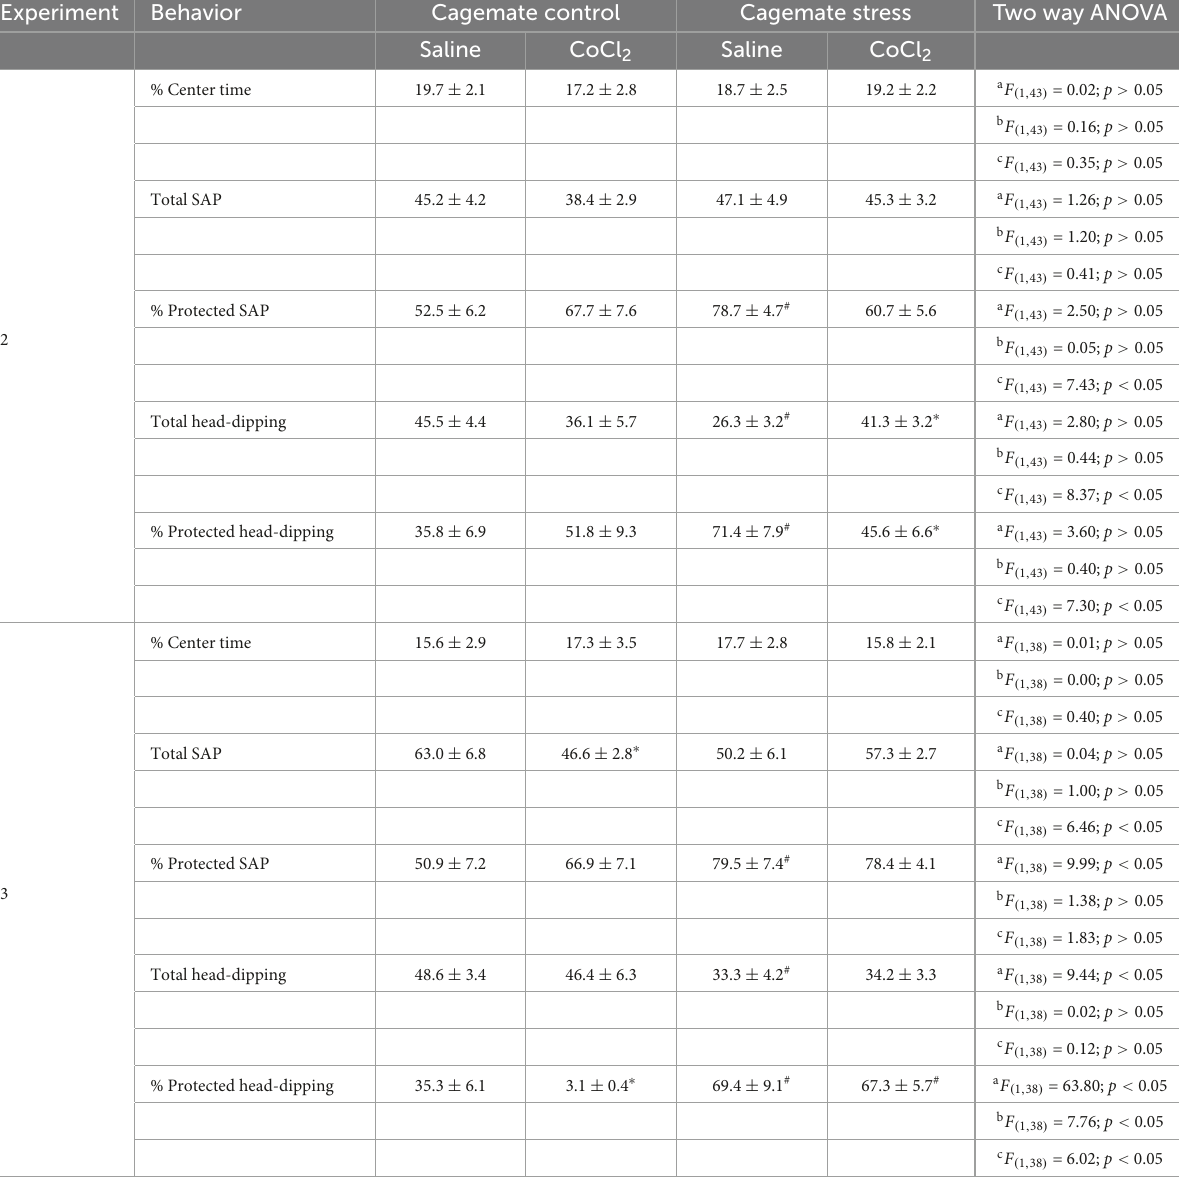
TABLE 3 Effects of saline or CoCl 2 (1 mM/0.1 µ L) inactivation within the ACC (experiment 2) and amygdala (experiment 3) in anxiety induced by living with a conspecific submitted to chronic stress in mice exposed to EPM. Experiment Behavior Cagemate control Cagemate stress Two way ANOVA Saline CoCl